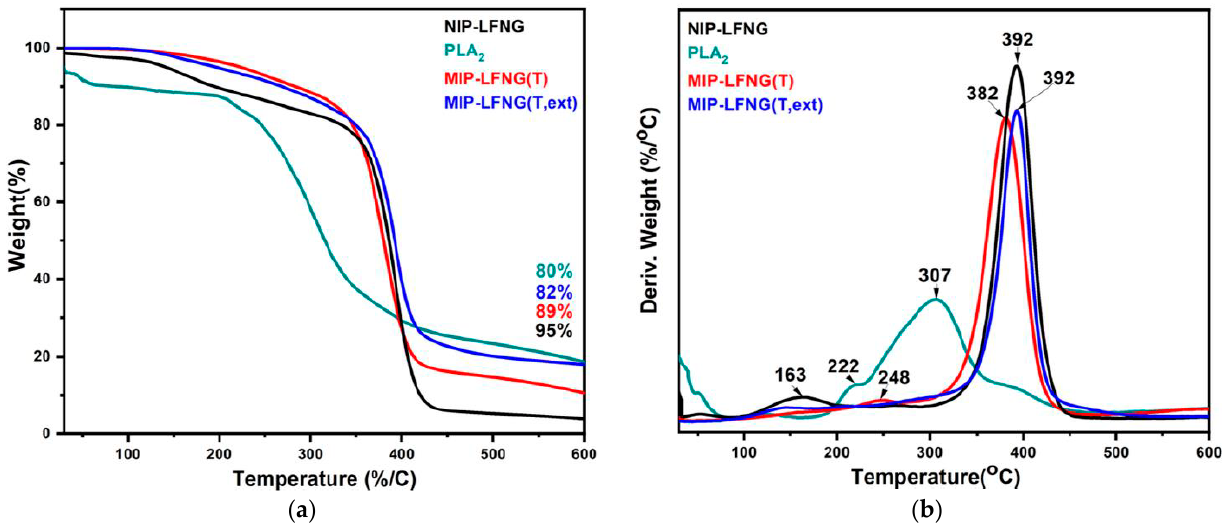
Figure 2. ( a )Thermal analysis diagram (TGA) and ( b ) derivative (DTG) of NIP-LFNG; PLA2 enzyme (PLA2); and MIP-LFNG (T) and MIP-LFNG (T, ext) before and after PLA2 extraction, respectively.